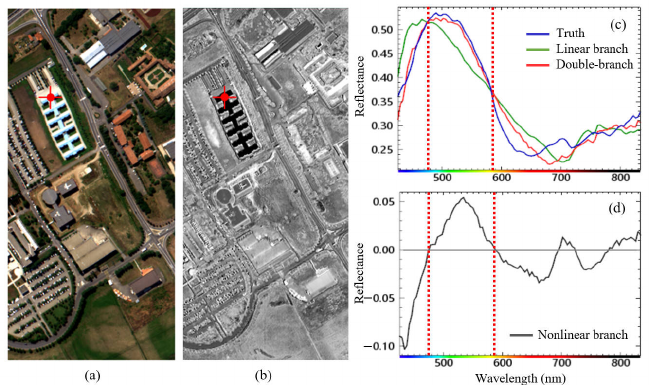
Figure 9. ( a ) Intermediate result generated by linear mixing branch; ( b ) Residual image generated by nonlinear residual branch; ( c ) The spectral curve of the red mark in ( a , b ), and the truth HSI; ( d ) The residual curve of the red mark in ( b ).